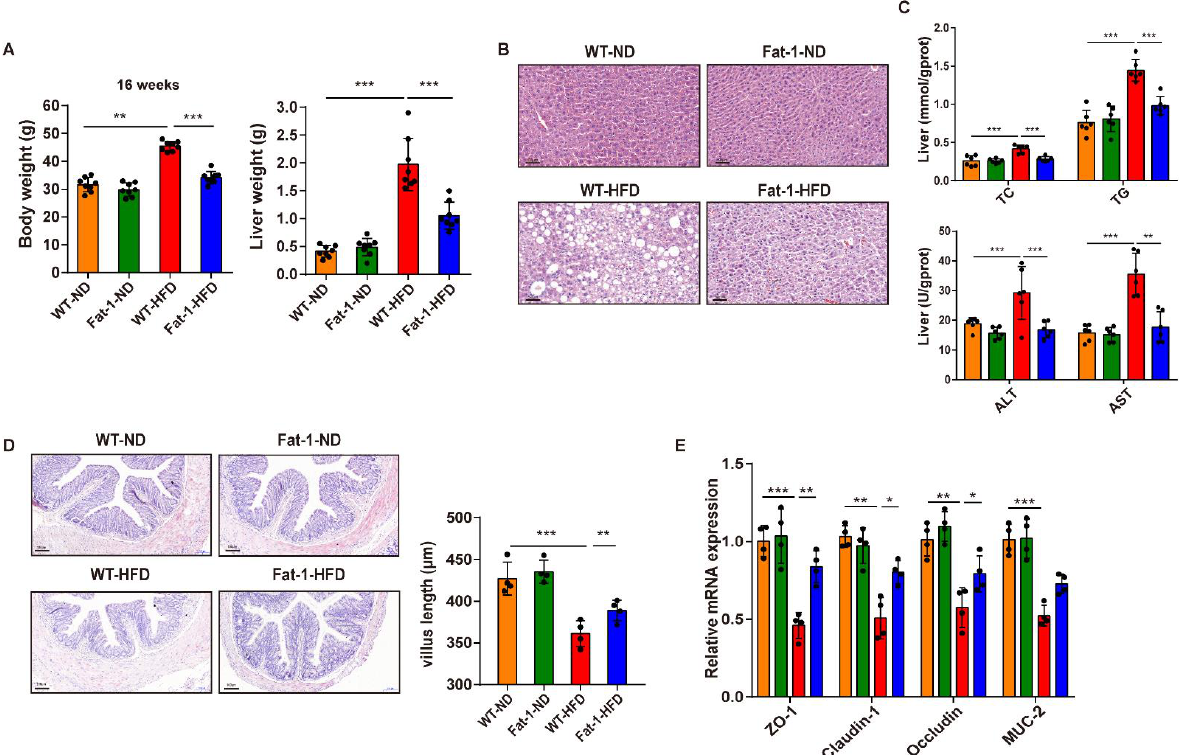
Figure 1. Endogenous n -3 PUFAs improve HFD-induced intestinal barrier dysfunction and hepatic steatosis. ( A ) Final body weight and liver weight at 16 weeks. ( B ) Liver pathology of different groups (200× magnification; scale bar = 50 μm). ( C ) Hepatic TC, TG, ALT, and AST content. ( D ) Representa- tive images of H&E- stained colon sections (100× magnification; scale bar = 100 μm). Villus length quantified using ImageJ software (right). ( E ) qPCR analysis of genes involved in the intestinal bar- rier function. Results are presented as mean ± SD ( n = 8 for each group). * p < 0.05, ** p < 0.01, and *** p < 0.001 by one- way ANOVA and Student’s t -test.